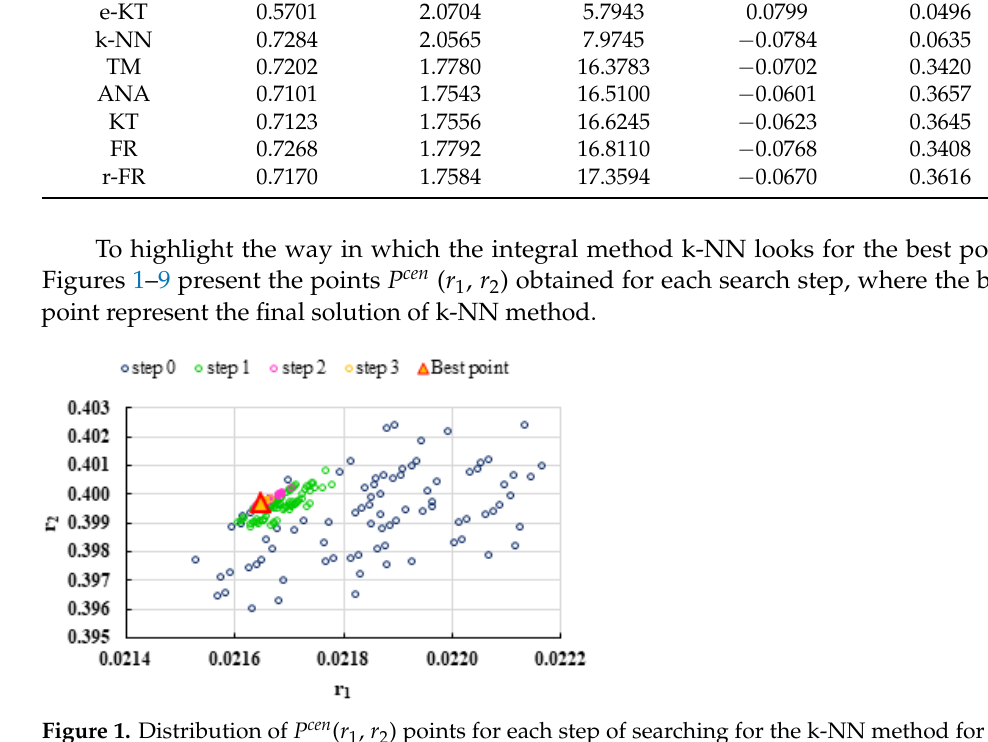
Figure 2. Distribution of P cen (r 1 , r 2 ) points for each step of searching for the k-NN method for the conditions imposed by LC2.